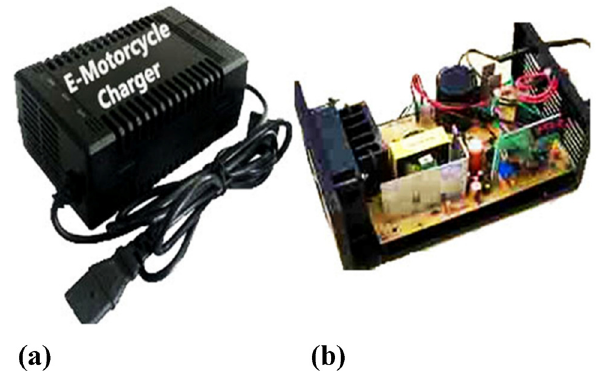
Figure 2: ( a ) Electric motorcycle charger and ( b ) inner compo - nents